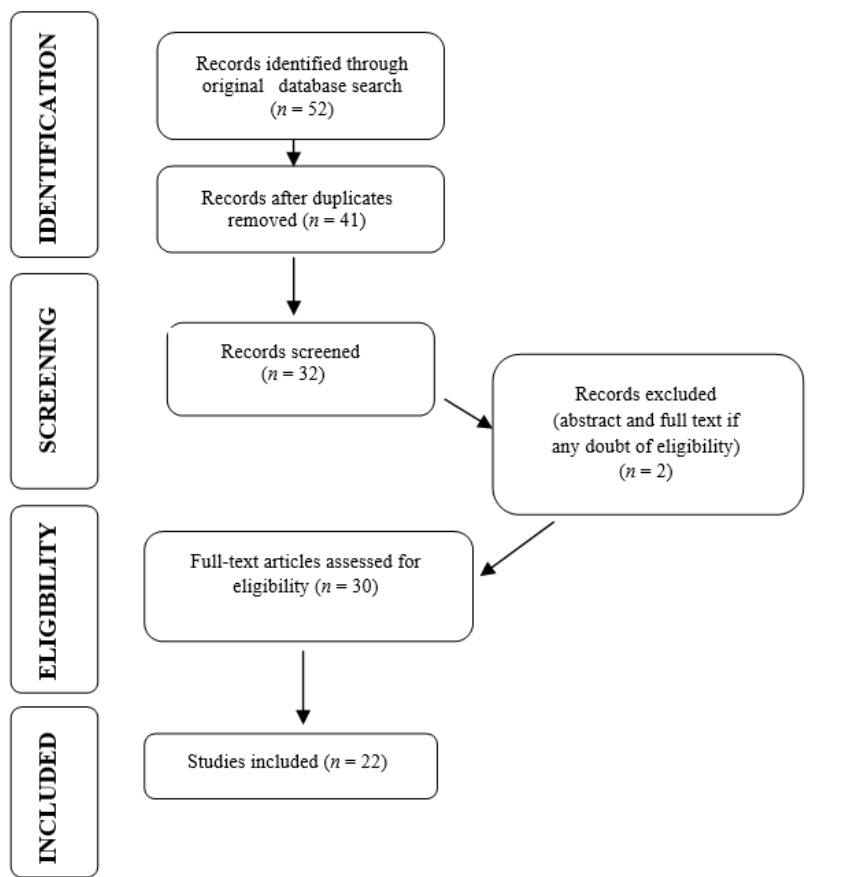
Figure 1. PRISMA flow diagram for research stages.